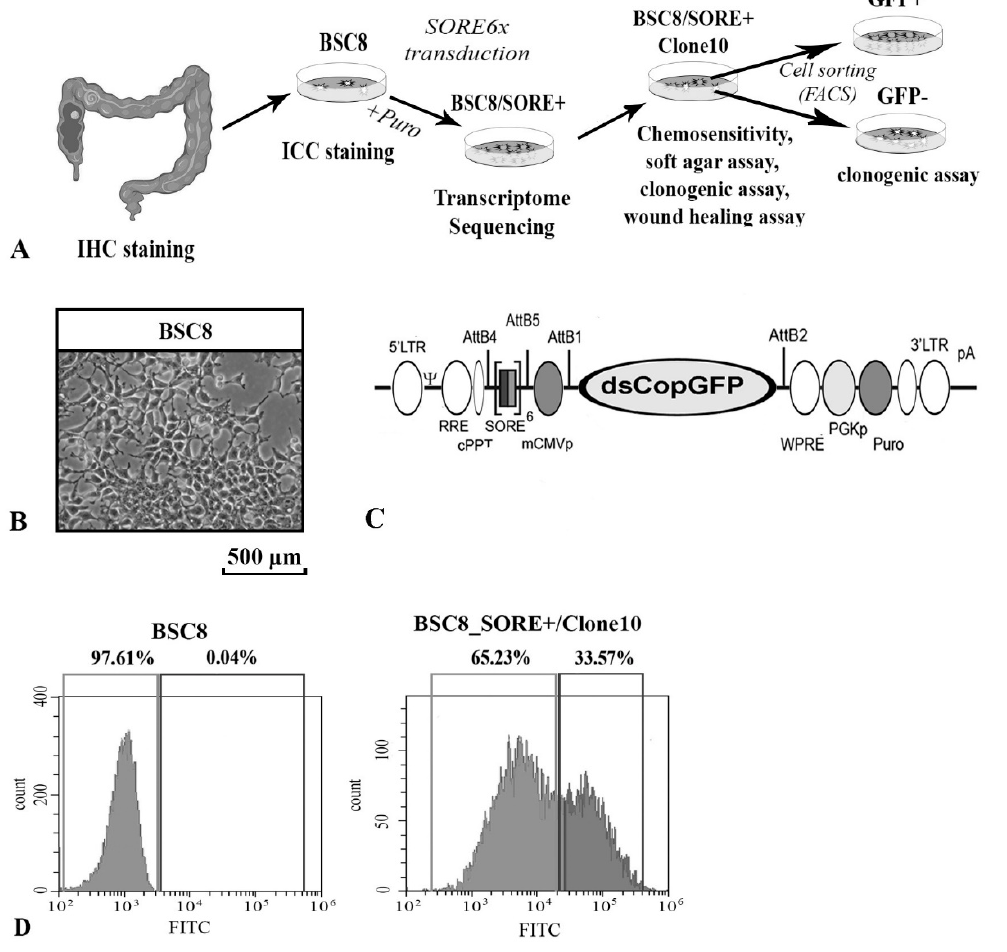
Figure 1. Obtaining a heterogeneous population of tumor stem cells. ( A ) Schematic representation of the experiment design. The source of the primary BSC8 cell line was human colon adenocarcinoma. CSC-like cells were obtained by viral transduction of the SORE6x reporter construct and subsequent selection on puromycin. ( B ). The BSC8 line cells in the culture. A polygonal cell shape typical to epithelial cells is noted. ( C ). SORE6x reporter plasmid constructed. The dsCopGFP gene and the Puro gene are under the control of the six-fold repeated responsive element from the Nanog gene promoter. ( D ). Histogram of the BSC8 and BSC8_SORE+/Clone 10 cell distribution according to the degree of fluorescence. The presence of two populations of the BSC8_SORE+/Clone 10 cells is determined, and the levels of fluorescence of these populations differed 100 times.